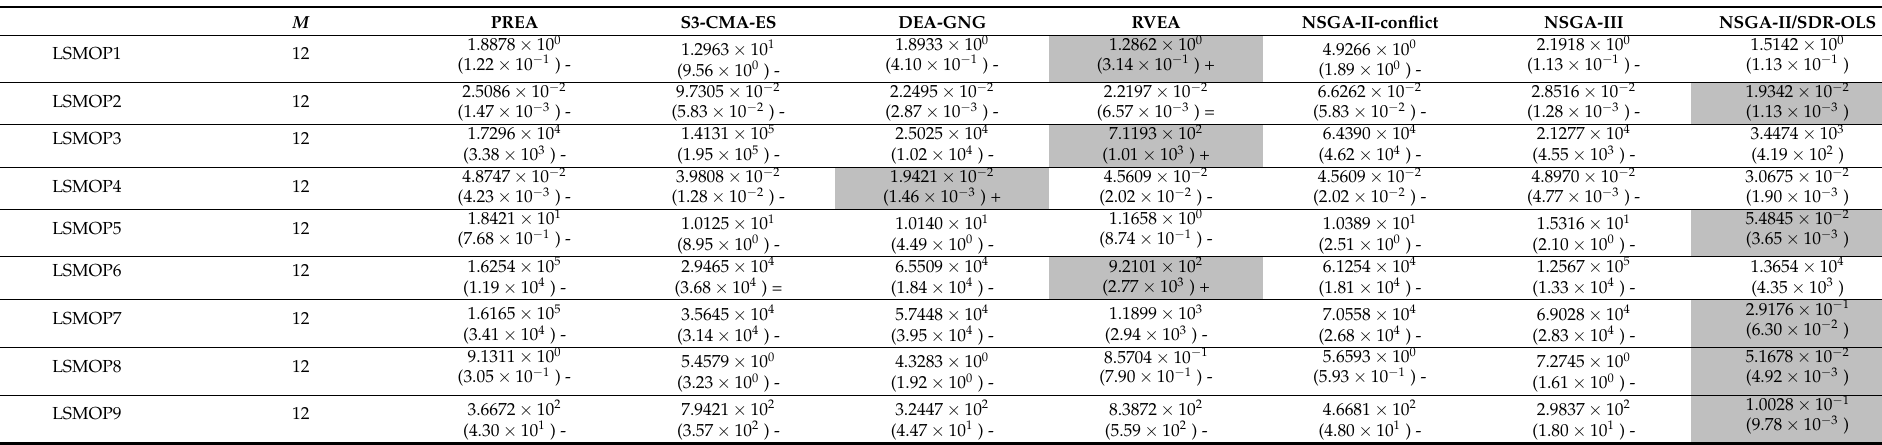
The gray background represents that this algorithm has the best performance on this problem. The number in the brackets represents the standard deviation, and the number out of the brackets represents the mean values. “+/-/=” means that the relevant algorithm performs better than/worse than/as well as the NSGA-II/SDR-OLS algorithm. Same below table. Table 15. GD values for 9 twelve-objective benchmark